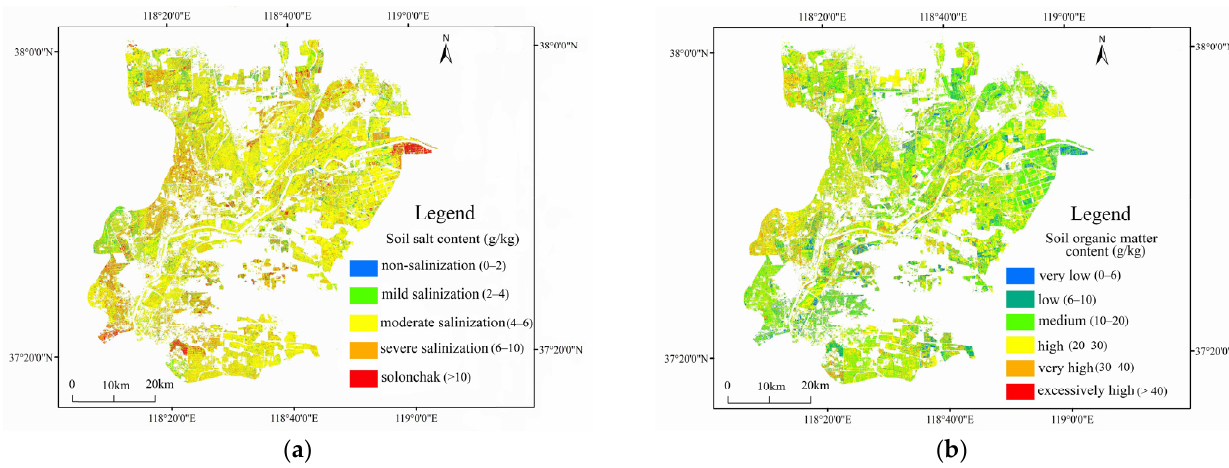
Figure 8. Spatial distribution of retrieved ( a ) SSC and ( b ) SOM values in the study area. Table 10. Area (%) of soil showing different grades of SSC and SOM in the study area.